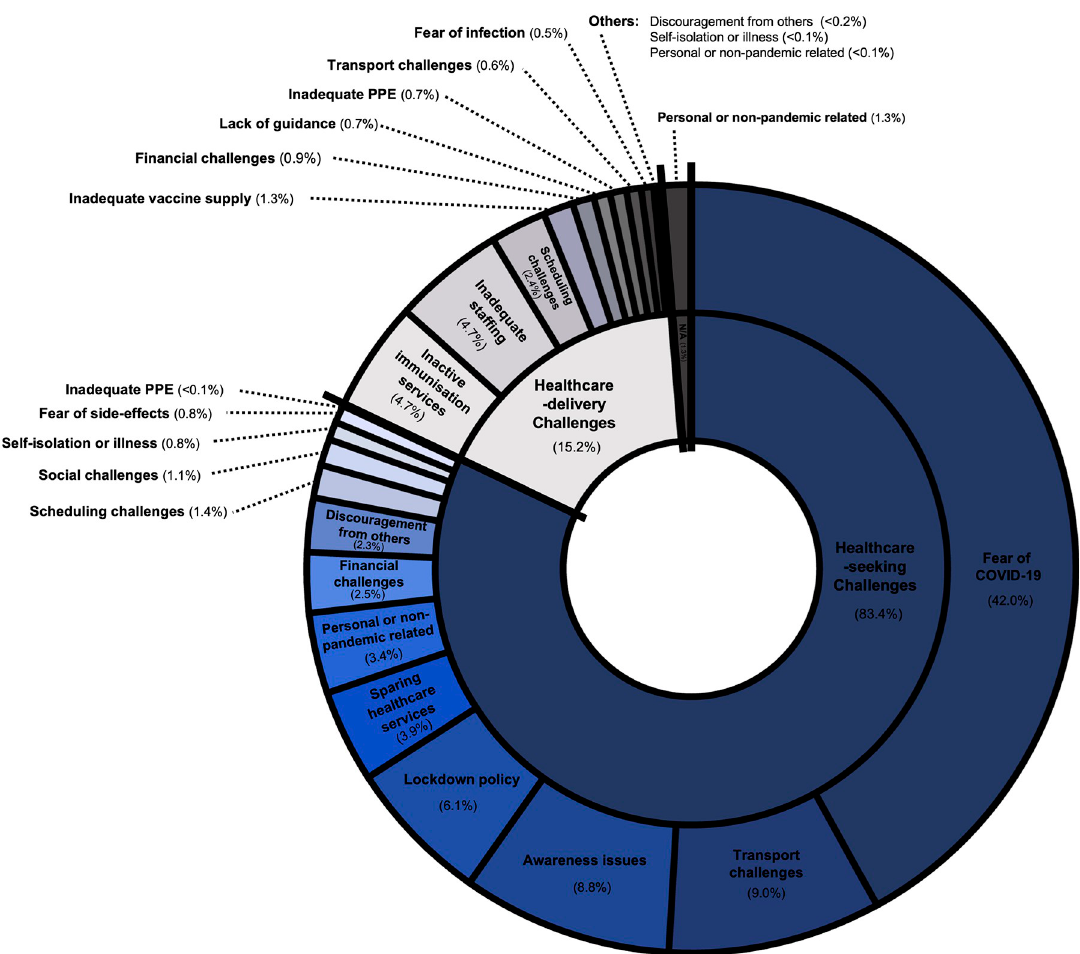
Fig 5. Coded reasons behind disruptions to routine child immunisations as visual proportions of total responses, subdivided by healthcare-seeking and healthcare-delivery challenges (n = 3,160). A minority of causes did not apply to either category and were denoted as